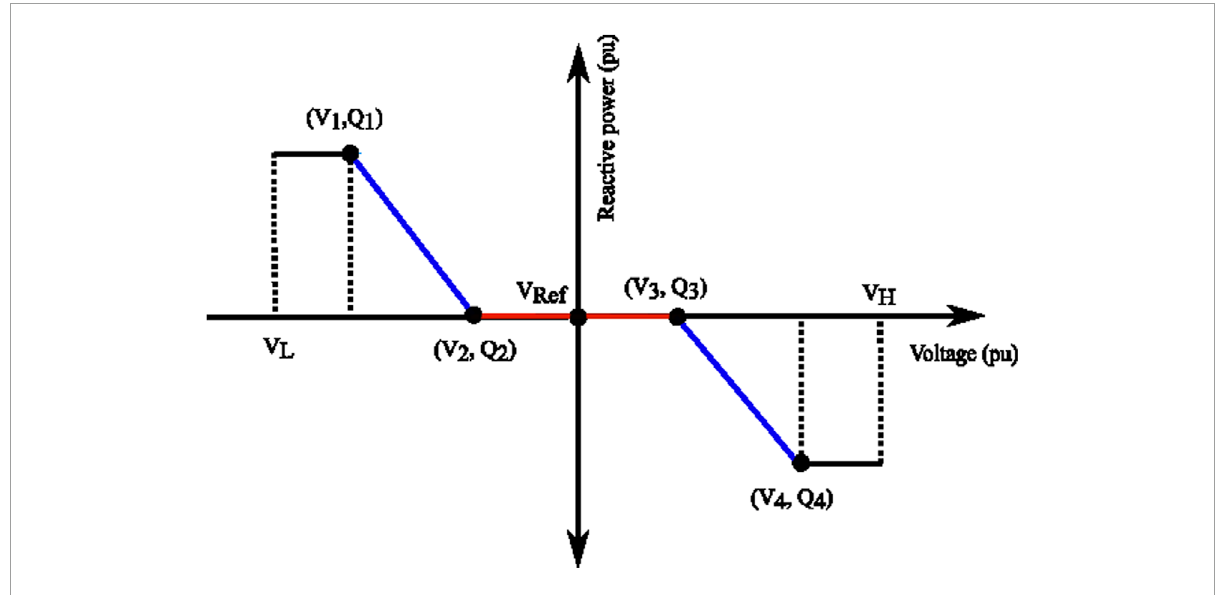
FIGURE 1 IEEE standard 1547-2018 V-Var Mode (pho,